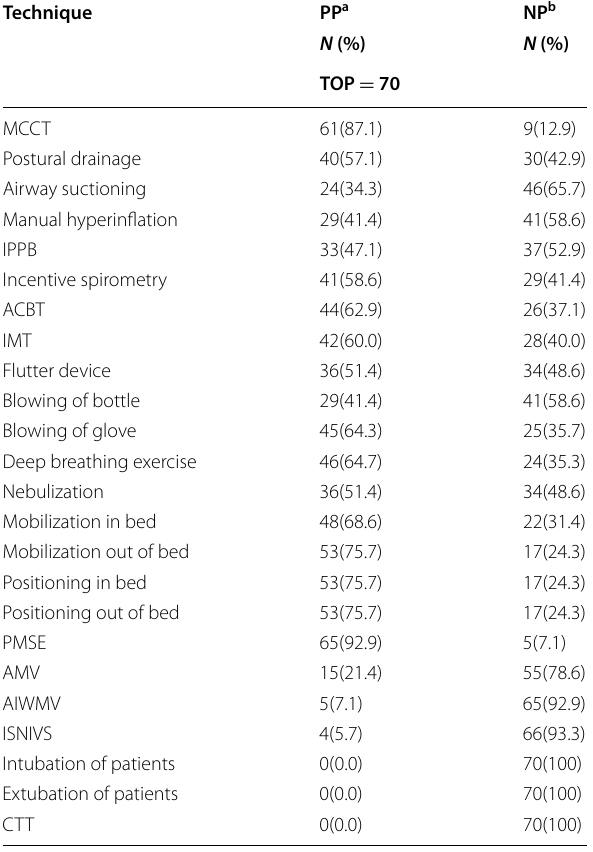
Table 4 Perception of HCPs about PTs’ treatment